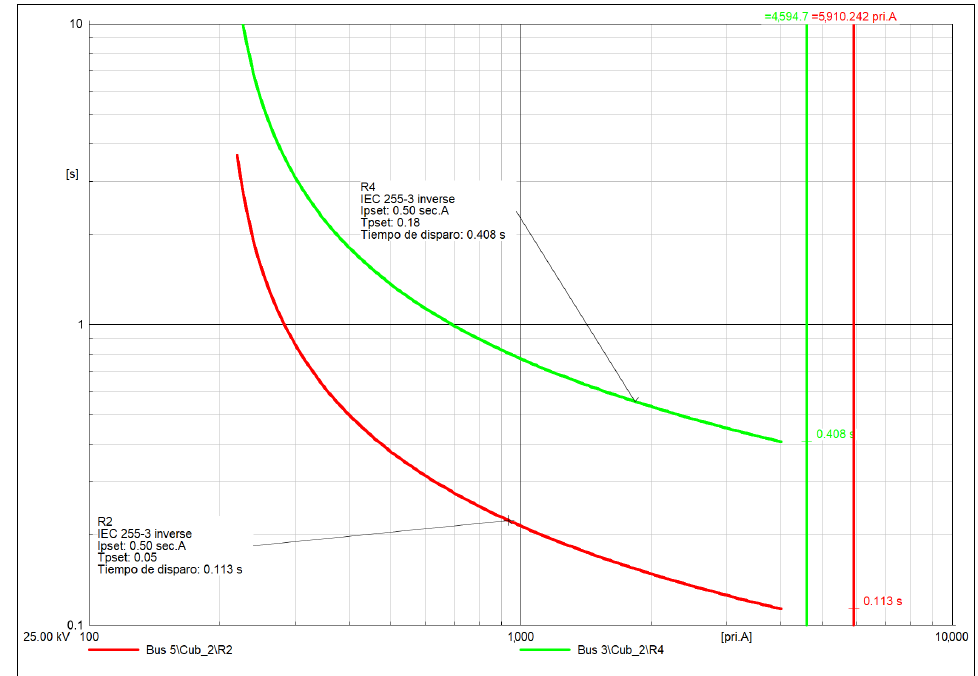
Figure 15. Coordination curve R4–R2 line fault DL-5 scenario